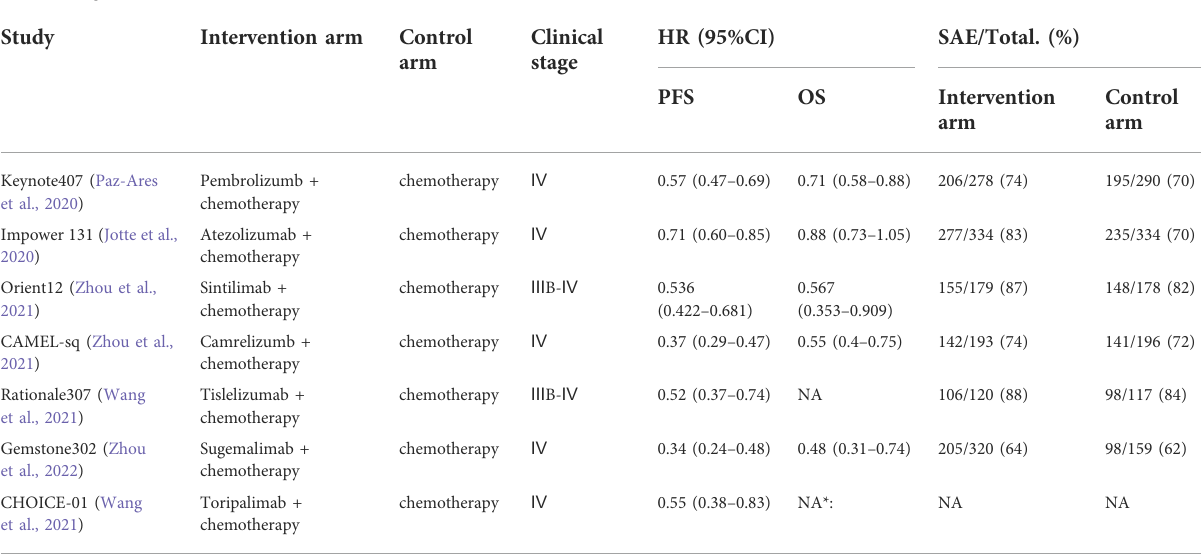
TABLE 1 Key information of included